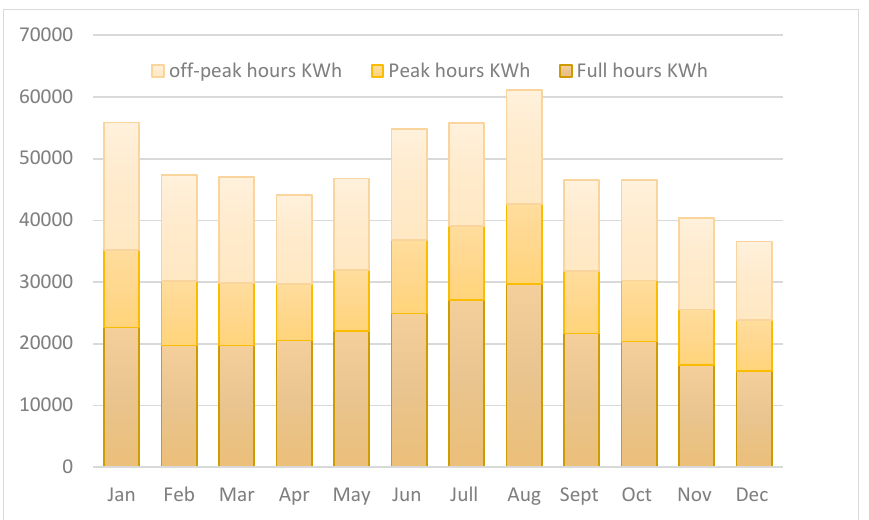
Figure 5. Monthly electrical load of the factory 3 — Fez 2021.